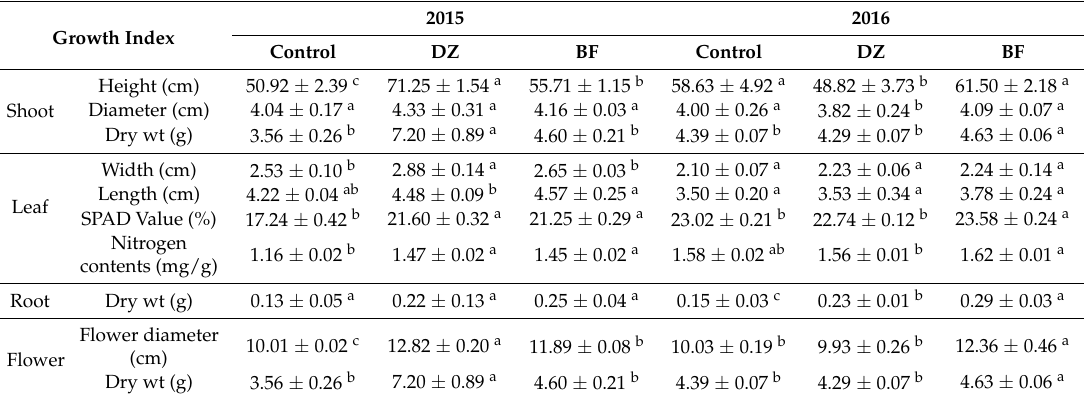
Table 1. Effects of chemical fungicide and biological fungicide on the growth of